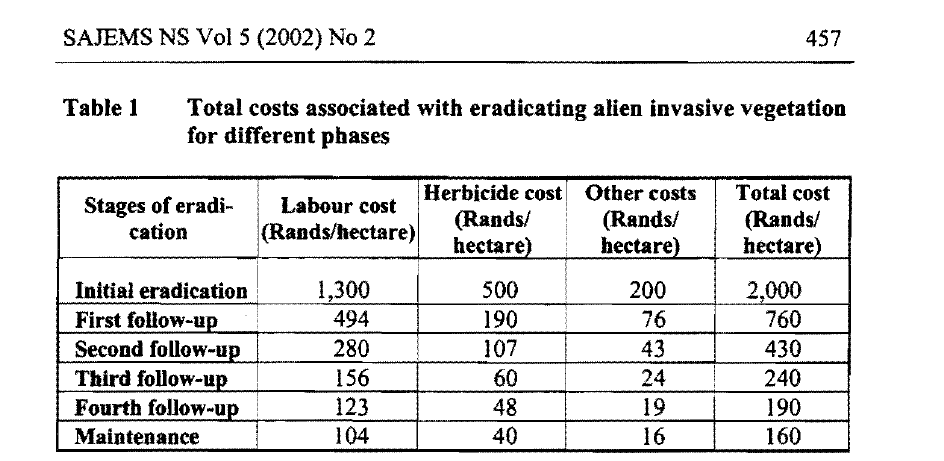
Total costs associated with eradication in the study area